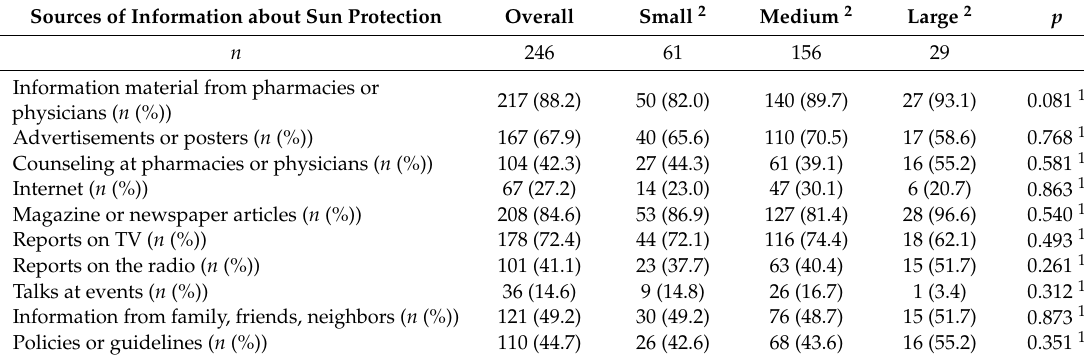
Table 4. Sources of information about sun protection used by directors of 246 nurseries in Bavaria, southern